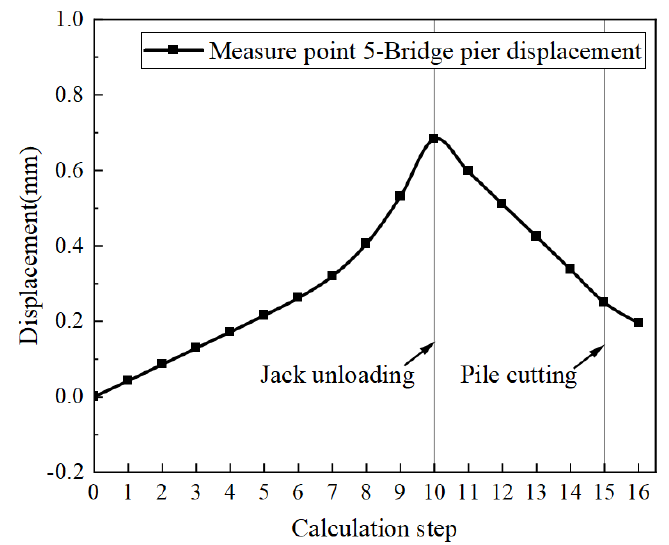
Figure 9. Displacement of the bridge pier calculated by numerical modelling.